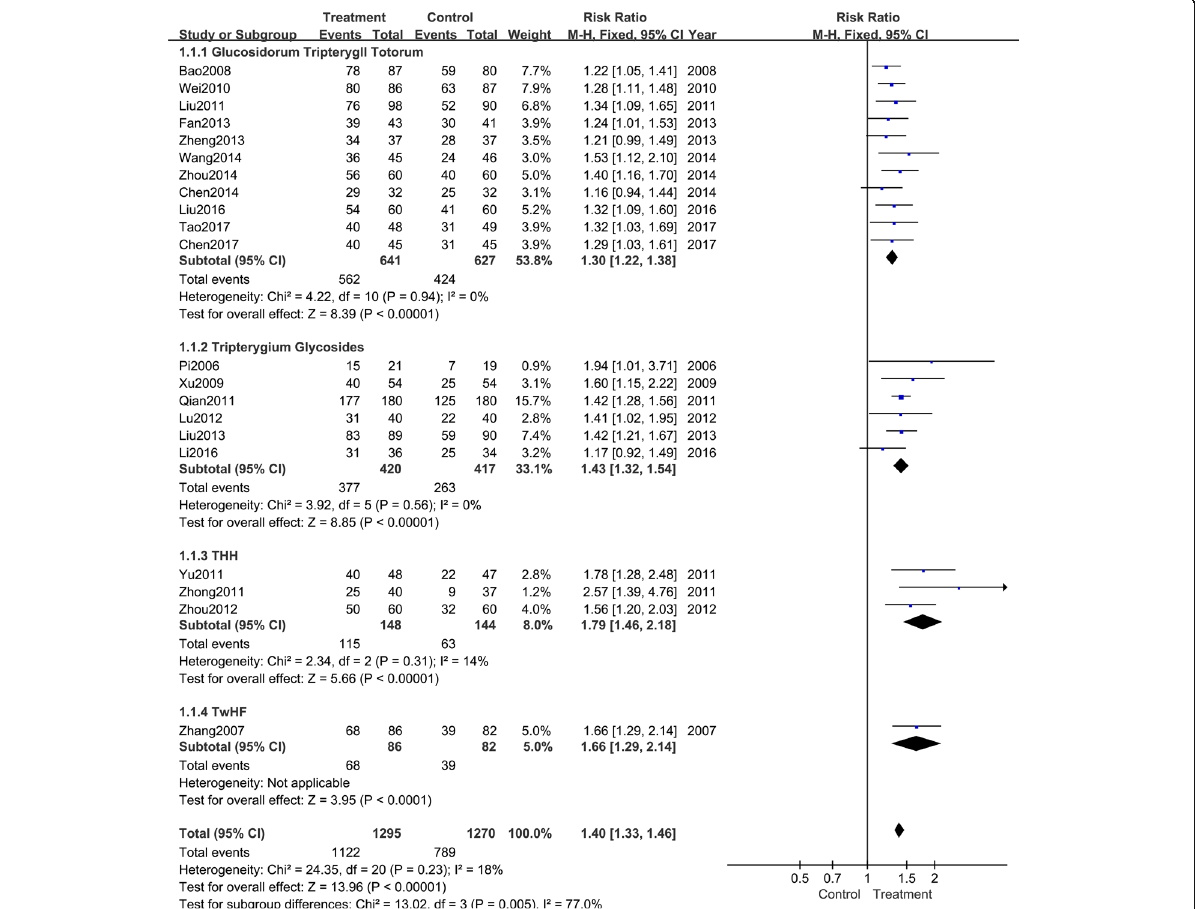
Fig. 4 Meta-analysis of the effectiveness rate of Tripterygium preparations combined with antihistamines versus antihistamines. CI indicates confidence